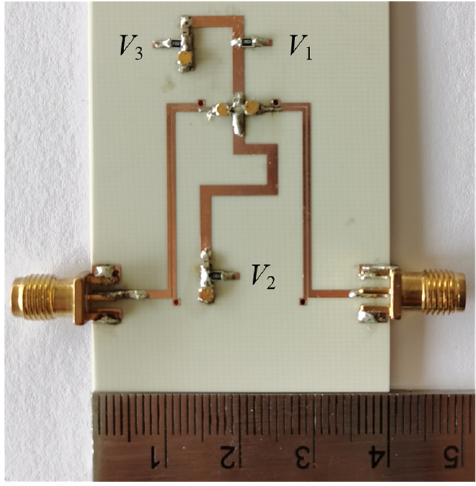
Figure 11. Photograph of the fabricated filter.